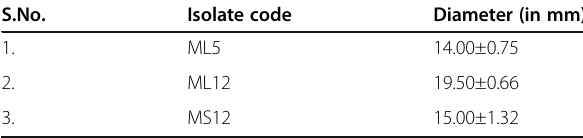
Table 2 Secondary screening of alkaline protease-producing bacterial isolates using zone of inhibition methods S.No.